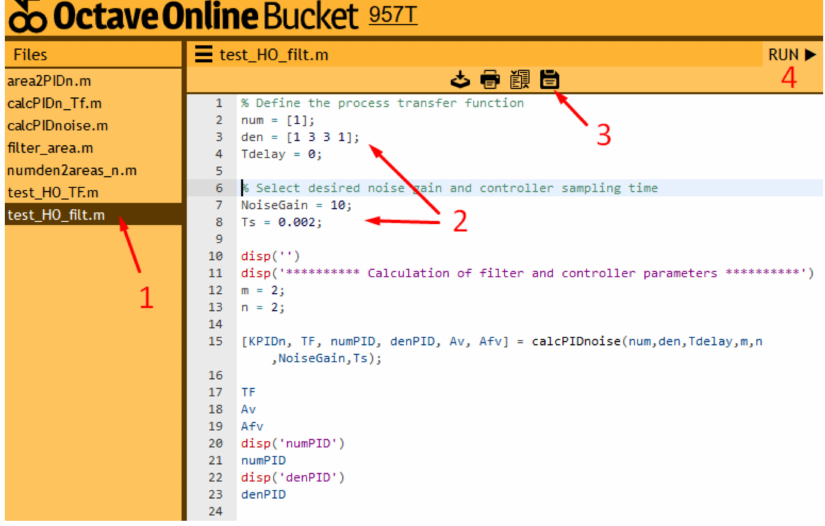
Figure 6. The layout of the OctaveOnline Bucket website (function